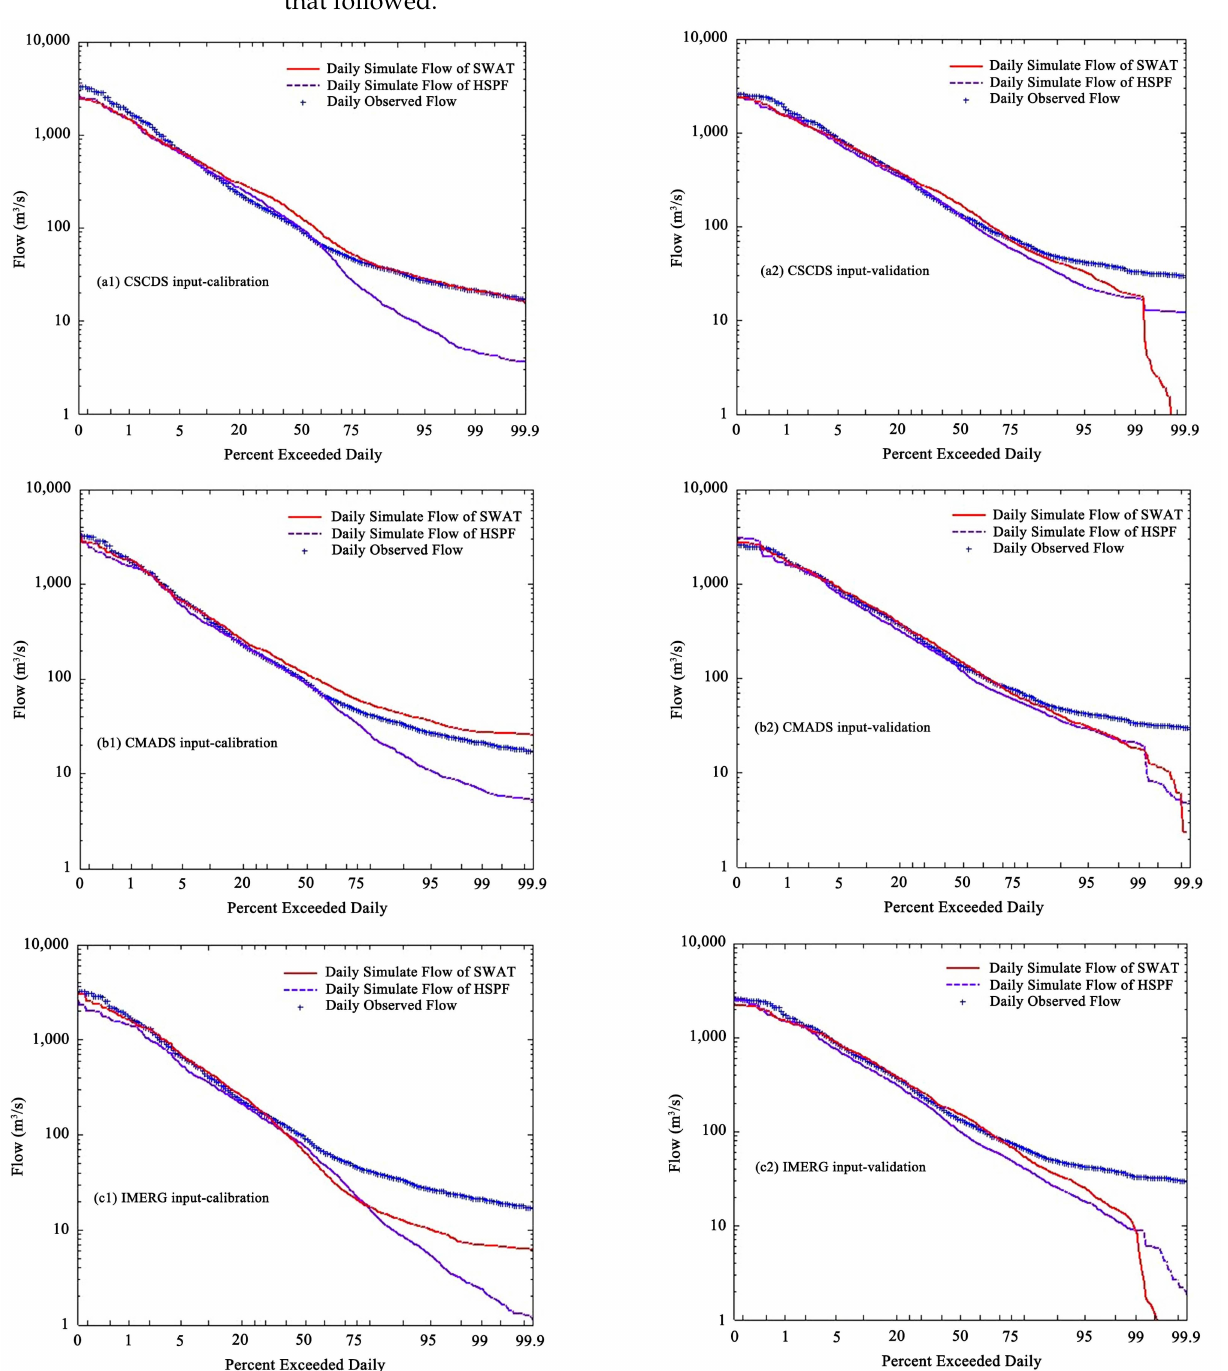
Figure 3. Comparison of the percentage of days when the SWAT and HSPF model results exceeded a certain flow with ( a1 , a2 ) CSCDS, ( b1 , b2 ) CMADS, and ( c1 , c2 ) IMERG